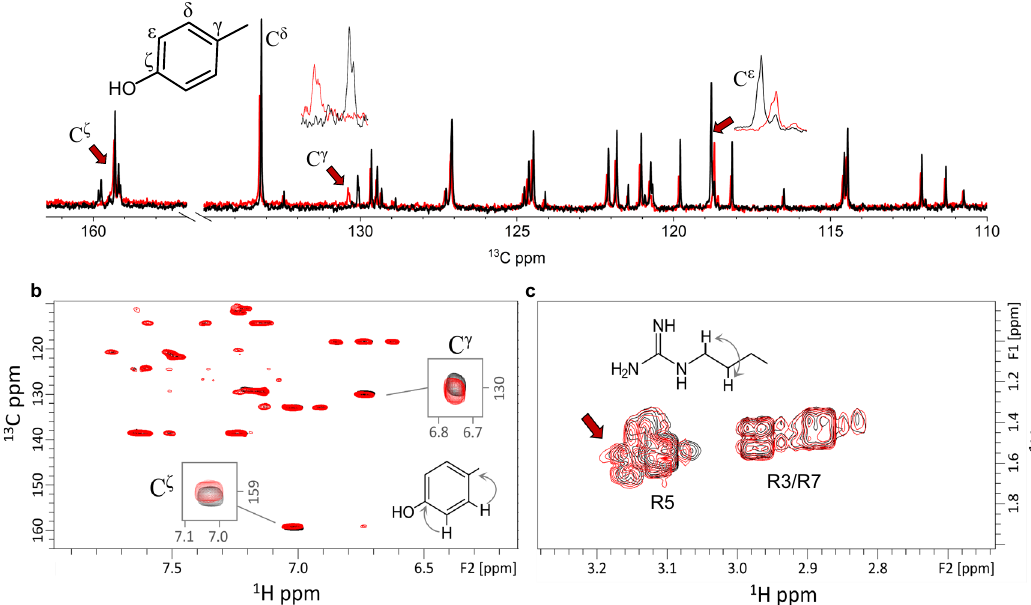
Fig. 6 | NMR determinesthe molecular mechanismofdropletformation. a The one-dimensional 13 CspectrumfortheWGR-1peptideat20(black,LLPS)and5(red, non-LLPS)mMin50mMtrisbufferpH10and300K.Arrowsindicatechemicalshift differences at the Y 14 aromatic ring. b Aromatic region of the 2D- 1 H, 13 C-HMBC